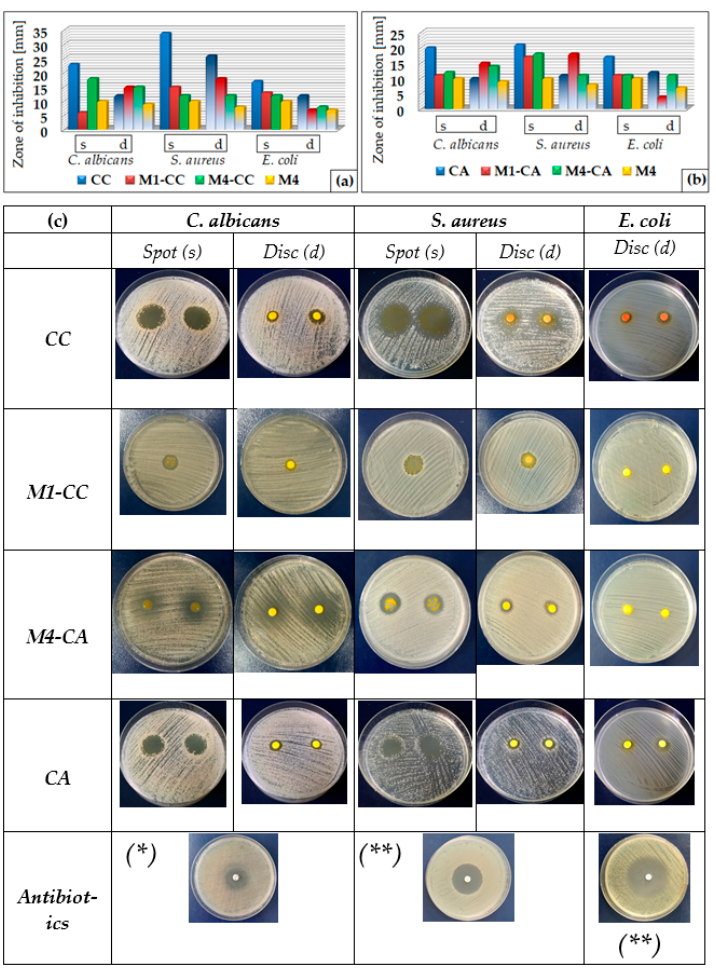
Figure 10. The antimicrobial activity of hybrid materials with ( a ) CC, ( b ) CA, and ( c ) the difference between the antimicrobial activity of the alcoholic solutions of the native dyes, that of the dyes encapsulated in siloxane matrices, and that of the antibiotics (* Fluconazole (25 μ g/mL), ** Ciprofloxacin (5 μ g/mL)).